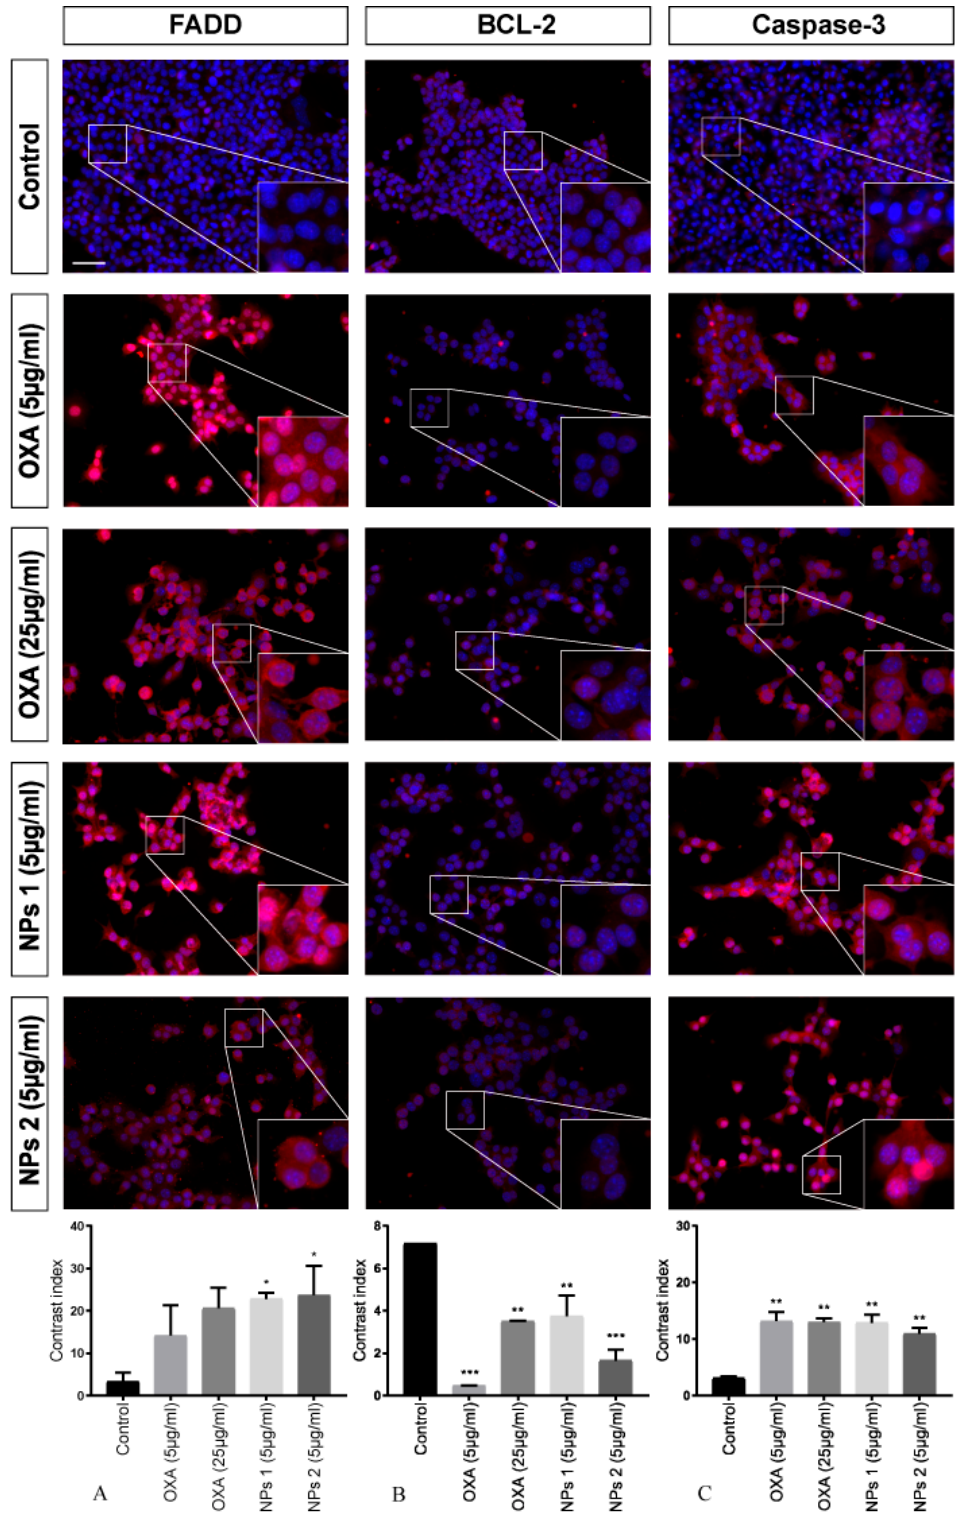
Figure 5. Detection of FADD, BCL-2, and caspase-3 after 48 h of treatment. CT-26 cells stained with DAPI (blue), anti-FADD, anti-BCL-2, and anti-caspase-3 antibodies (red). Contrast index for FADD, * p < 0.05 ( A ); BCL-2, ** p < 0.01, *** p < 0.001 ( B ); and caspase-3, ** p < 0.01 ( C ). Scale bar: 50 μ m.